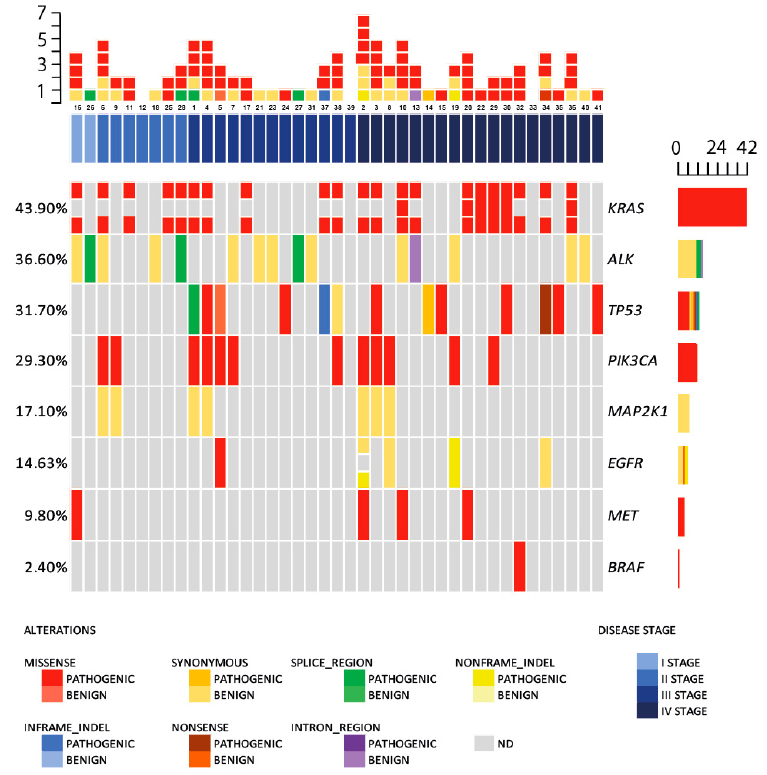
Figure 1. Summary of patients according to non-small cell lung cancer (NSCLC) stage and cell-free DNA (cfDNA) gene mutations in T0 group samples. Mutations are color-coded in gradient from pathogenic to benign after type of mutation: red (missense); blue (in-frame indel); orange (synonymous); brown (nonsense); green (splice site); violet (intronic region); yellow (non-frame indel). NSCLC patient stages are color-coded in blue gradient from darkest—IV stage to I stage. Grey colored squares represent non-detected (ND) mutations.